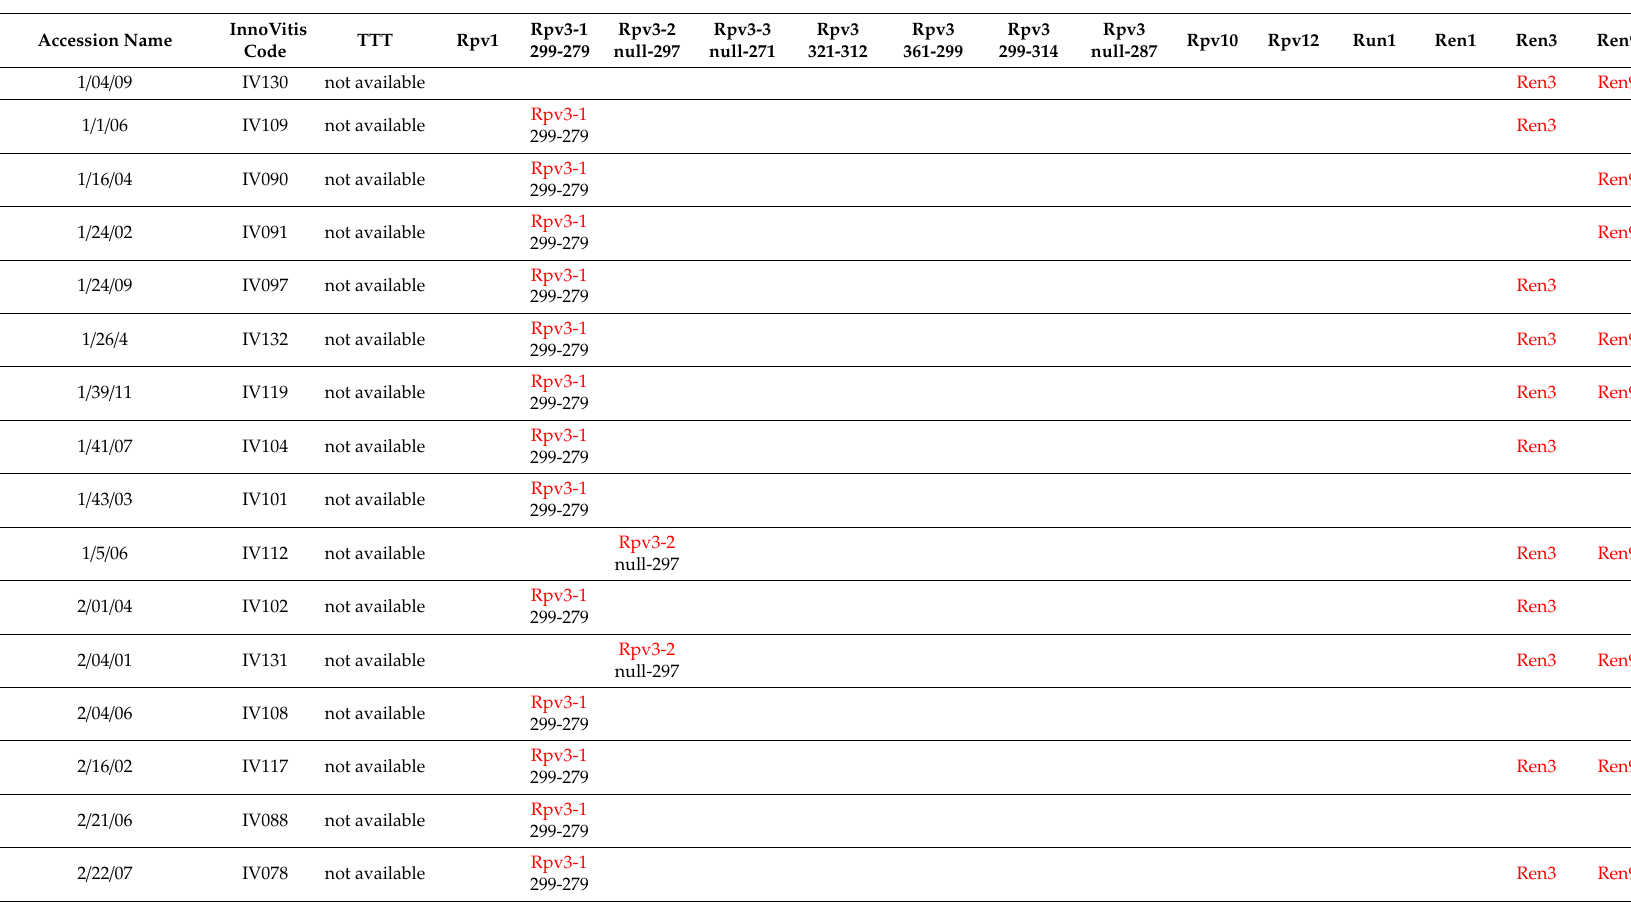
Table 1. Characterization of resistance ( R ) loci in each studied accession based on the “all-vs-all” approach: The occurrence of the R -locus is highlighted in red, while its absence is represented by an empty